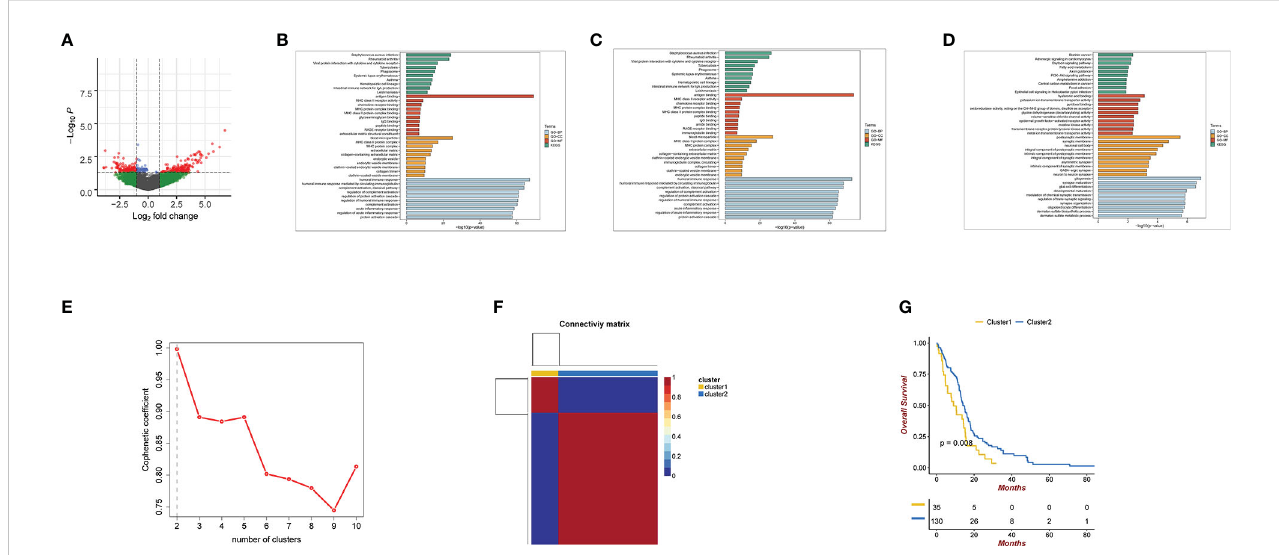
FIGURE 1 (A) Volcano map of cluster1 and cluster2 differential genes. Green coloration denotes genes with FC cutoff but no P cutoff. Green represents genes that meet FC cutoff standards but fail to meet P cutoff standards. Blue represents genes that meet FC cutoff standards but fail to meet P cutoff standards.Red represents genes that both meet FC cutoff and P cutoff standards.Gray represents genes that both meet FC cutoff and P cutoff standards (B) GO and KEGG analyses for Exosome pattern genes. (C) GO and KEGG analyses for cluster1. (D) GO and KEGG analyses for cluster2. (E, F) using NMF clustering method, the best clustering of exosome pattern genes is cluster1 and cluster2. The phenotypic coef fi cient decreases with the number of clusters. (G) Kaplan-Meier curves for the cluster1 and cluster2 differential genes.